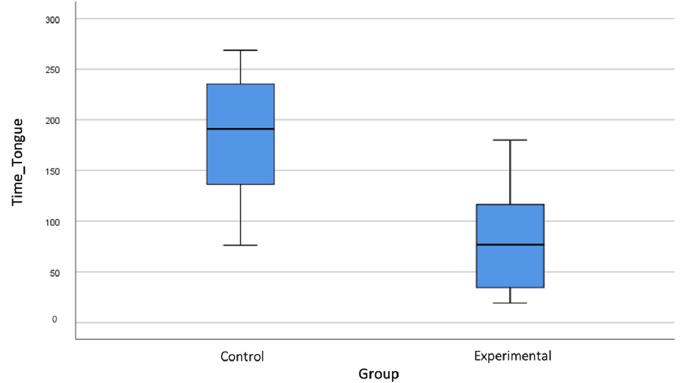
Figure 2. Bloxplot showing differences between control and experimental groups in tongue numb- ness recovery time.